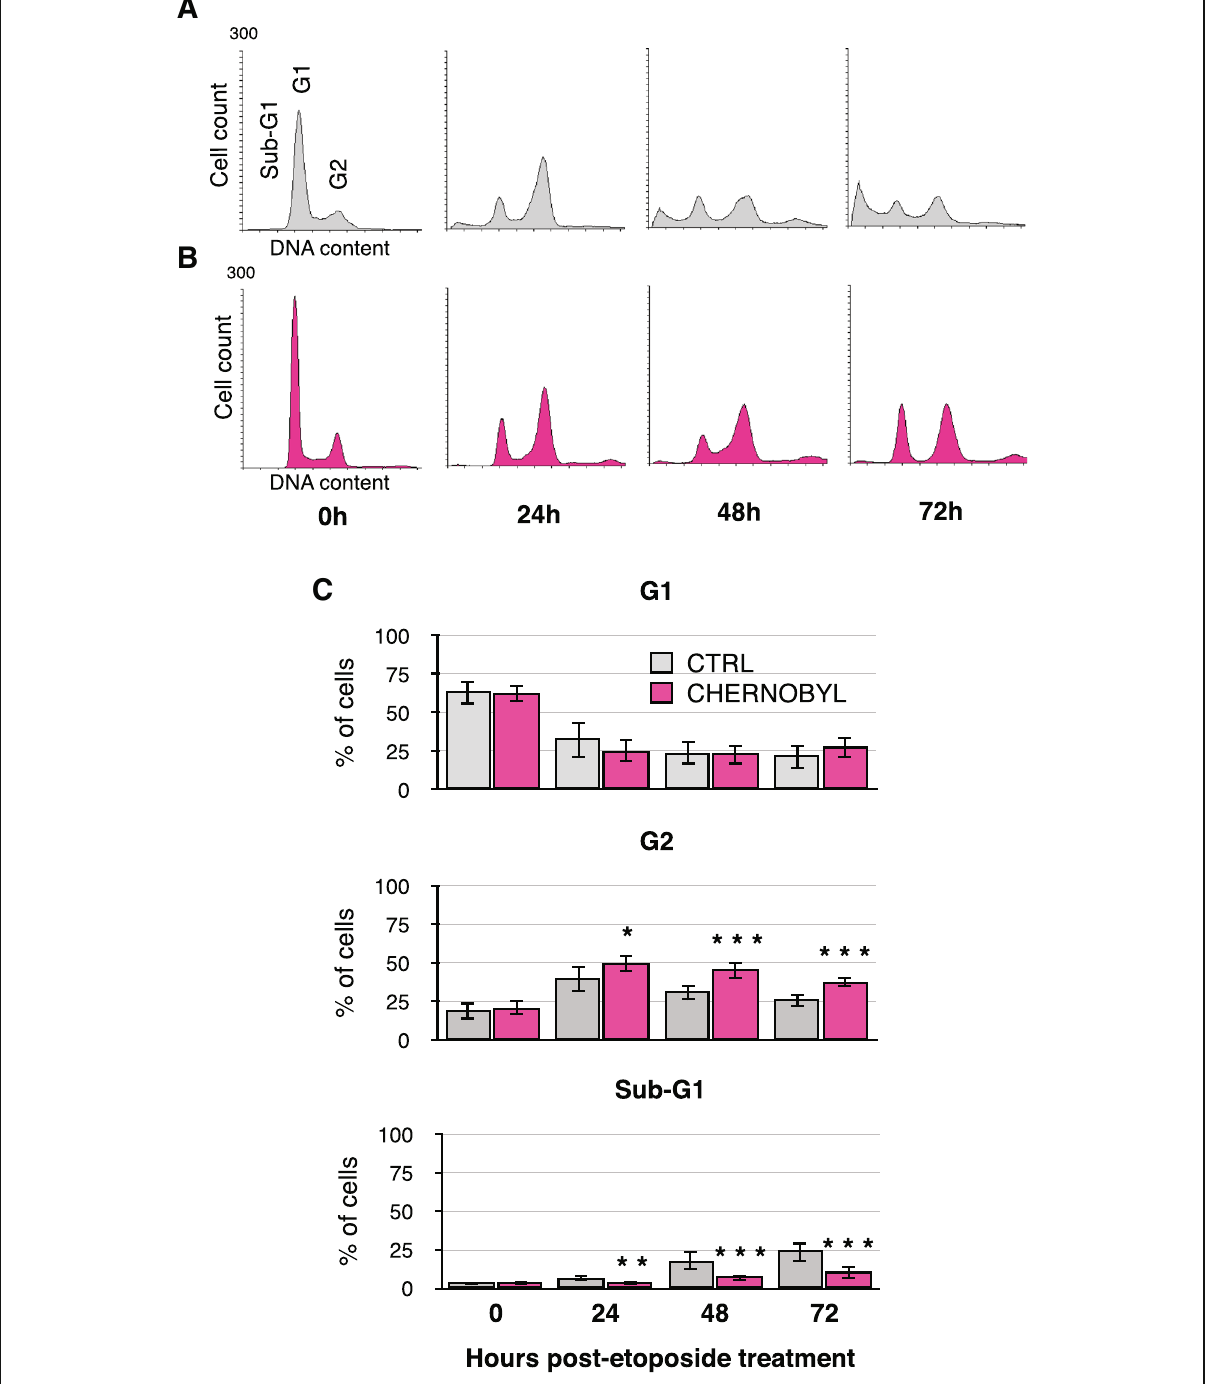
Fig. 4 After DNA damage Chernobyl fibroblasts arrest stably at G2 phase. Example propidium iodide flow cytometry profile for one a .) control and b . Chernobyl cell line after 24, 48, and 72 h from etaposide treatment. c . The bar charts show the percentage of cells in G1, G2, and sub-G1 cell cycle phase for Chernobyl and control fibroblasts according to their DNA content by flow cytometry after 24, 48, and 72 h from etoposide treatment. The location of cells in sub-G1 (dying cells), G1, and G2 cell cycle phase are marked in the DNA histogram. The bar chart results are from three separate experiments using eight Chernobyl ( N = 24) and eight control ( N = 24) cell lines, variation is shown by standard deviation, and statistical analysis was done with Student ’ s t-test (* = p ≤ 0.05, ** = p ≤ 0.01, *** = p ≤